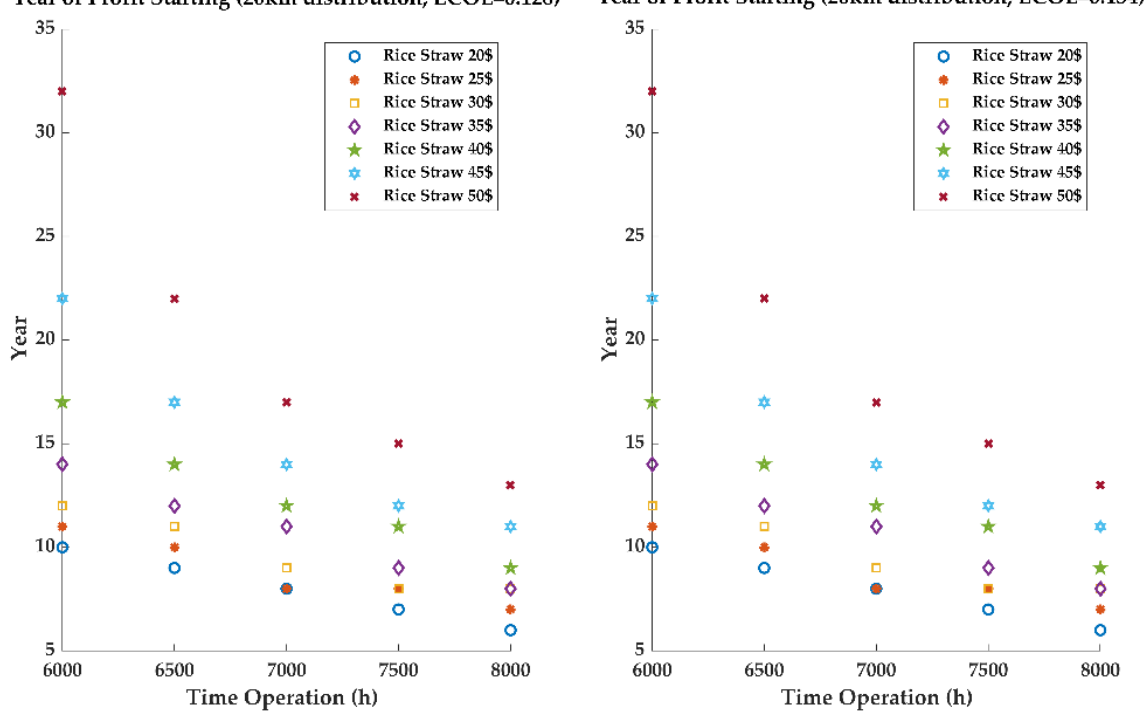
Figure 9. Year of profit starting at 20 km of medium voltage distribution length.